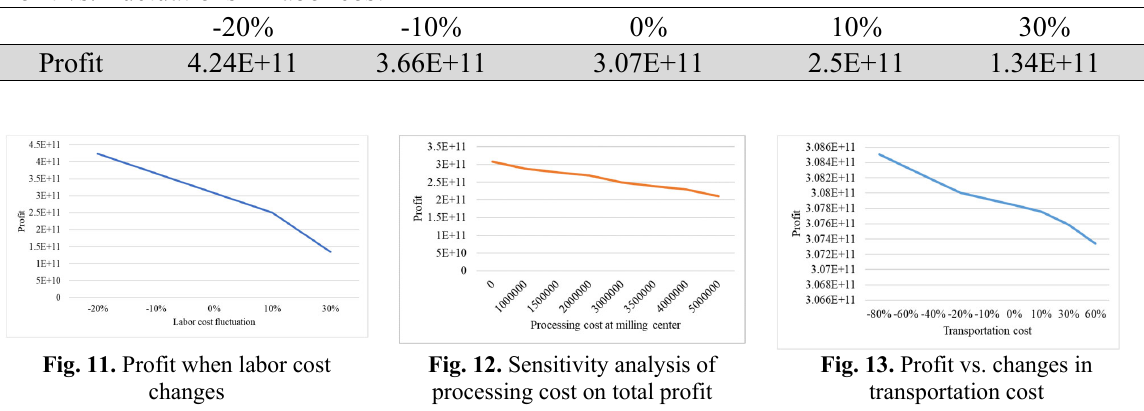
Fig. 11. Profit when labor cost changes